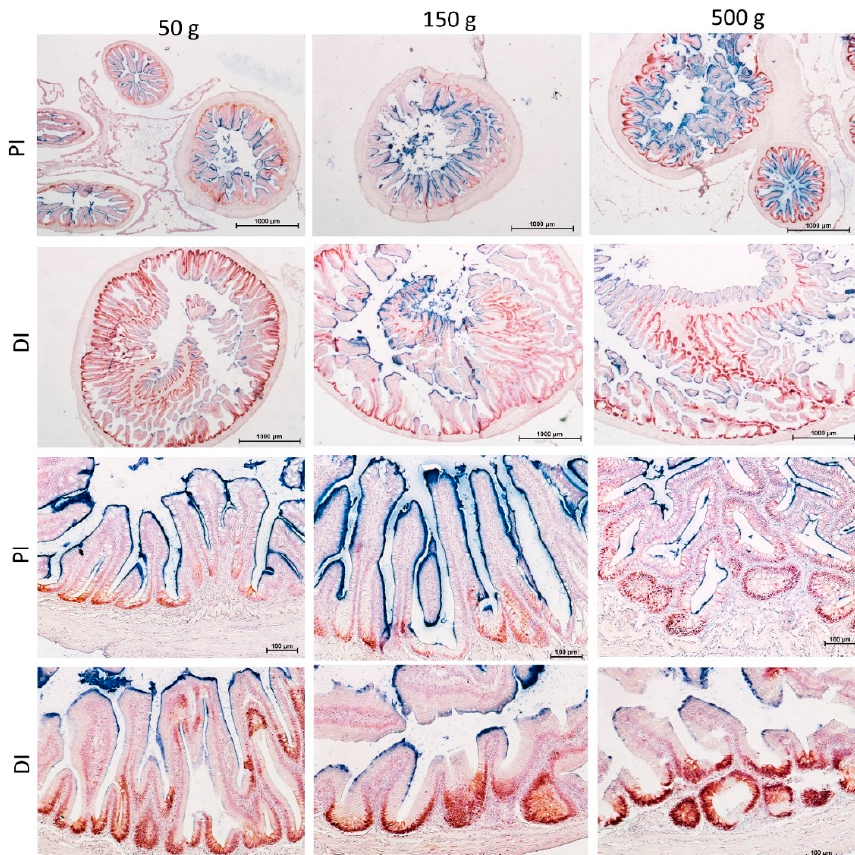
Figure 14. Proliferating cell nuclear antigen (PCNA) immunolocalization was observed within the intestinal folds at the basis of the villi in both proximal (PI) and distal (DI) intestine in all investigated stages. PCNA + cells were also found in correspondence of villi branching points in the proximal intestine. Cell proliferation was more intense and widespread in the distal compared to the proximal intestine in all investigated stages. Fully differentiated enterocytes expressing alkaline phosphatase (AP) activity were observed at the villi apex, but conversely, its expression was stronger and more widespread in the proximal compared to the distal intestine in all ages.